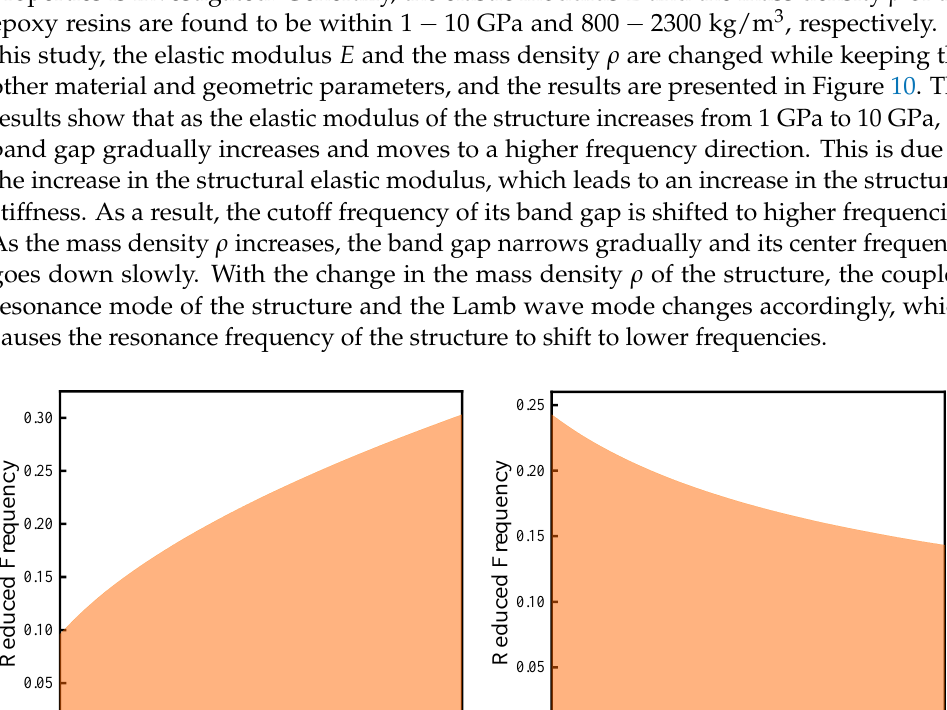
Figure 9. Relationship between the band gap characteristic and the parameter ratio 𝑒/𝑎 . ( a ) Relationship function curve and ( b ) eigenmode displacement vector field.